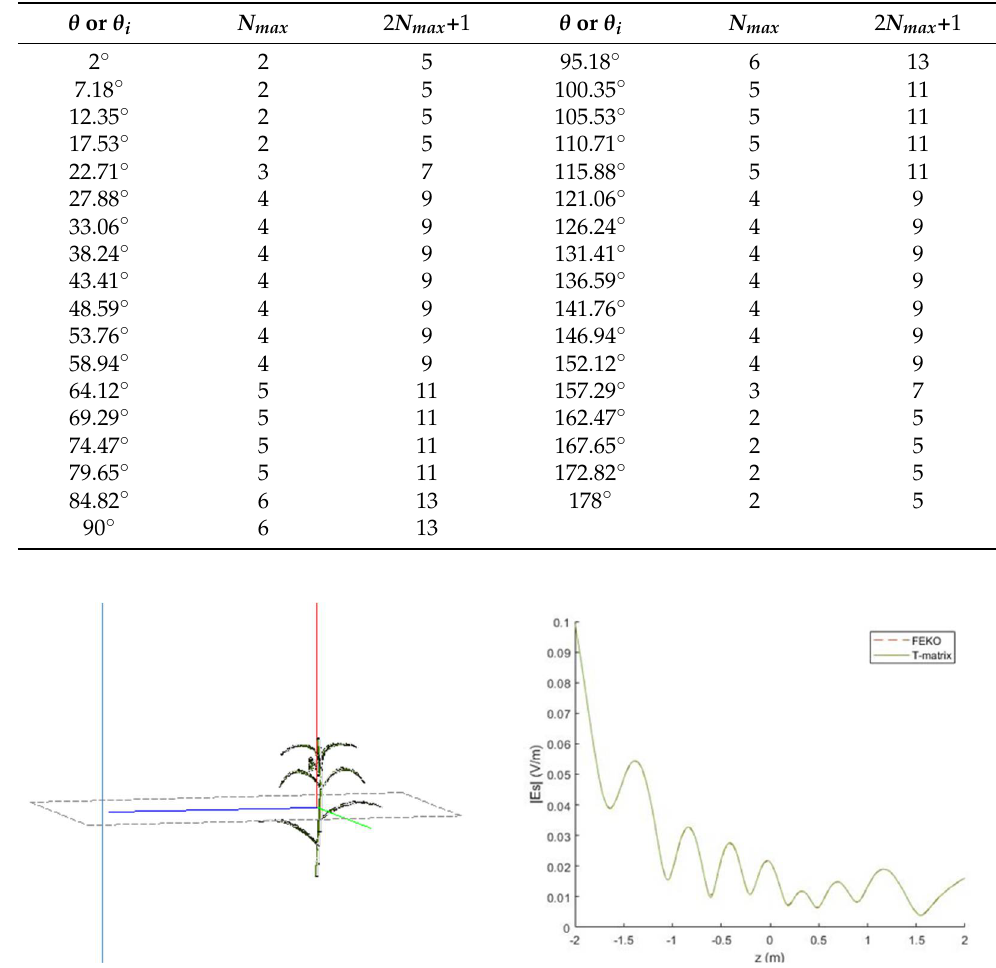
Table 2. The choice of N max for different θ or θ i .